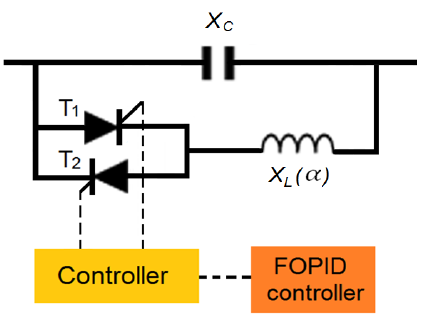
Figure 6. Schematic of a TCSC with the FOPID